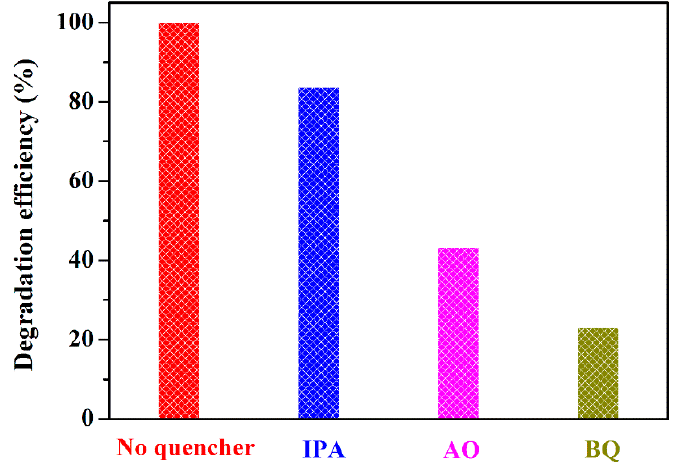
Figure 9. Impacts of various quenching agents on the photocatalytic activity of Ag/Ag 2 CrO 4 /BiOCOOH.